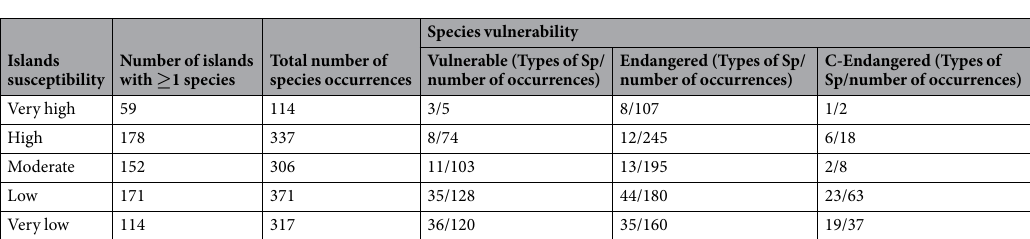
Table 2. Breakdown of distribution of species on different island susceptibility